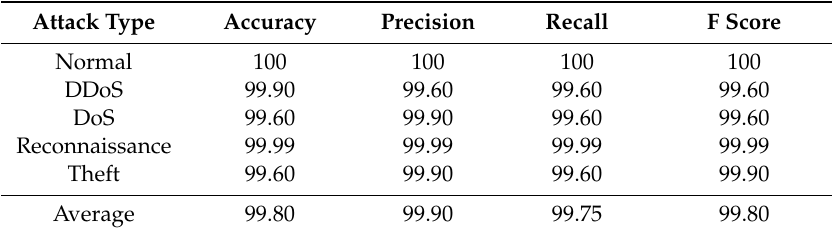
Table 9. Accuracy Precision, Recall, and F Score for Category.